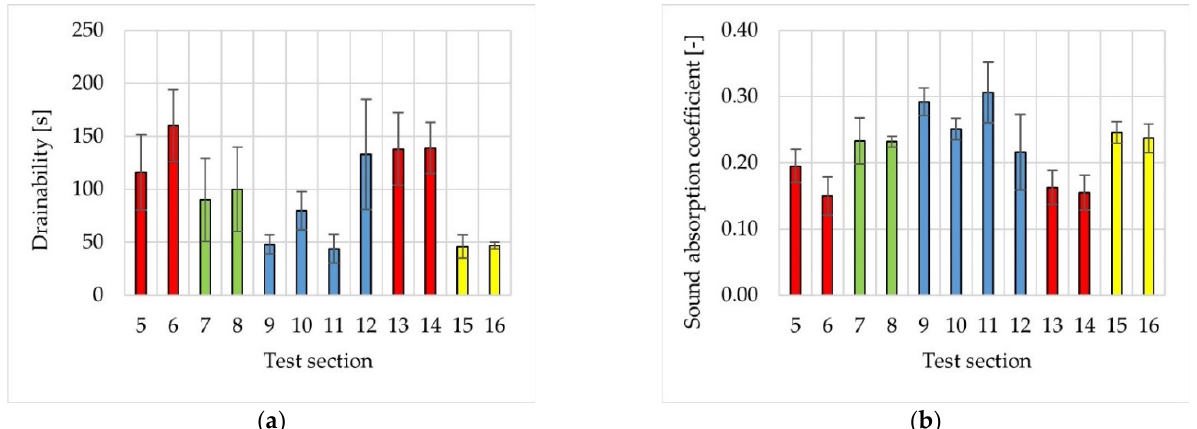
Figure 17. The results of water drainability ( a ) and sound absorption coefficient ( b ) on test sections.